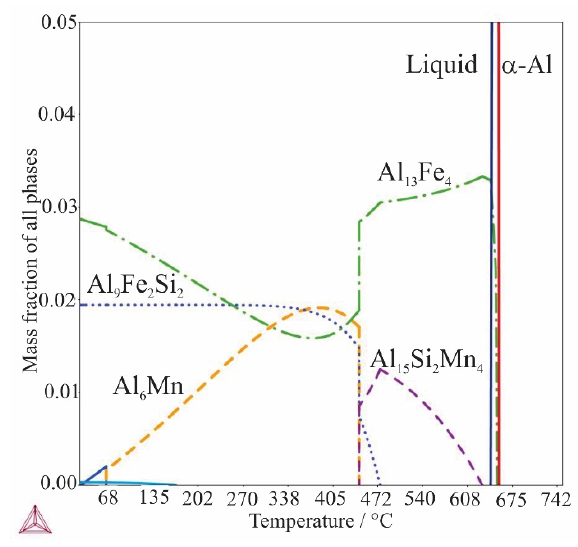
Figure 2. Thermo-Calc predicted phase stability in aluminium alloy EN AW 8006 with regard to the temperature.